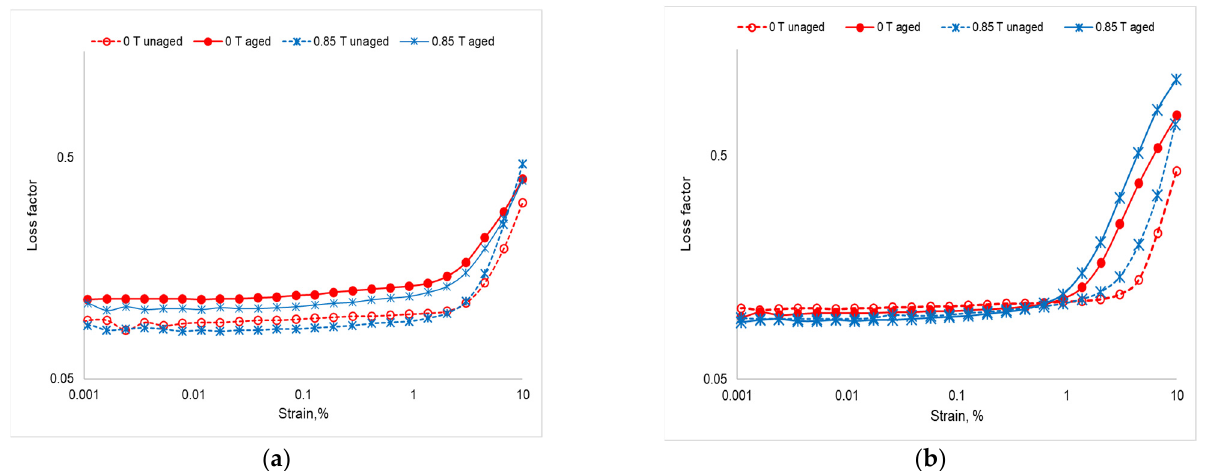
Figure 5. Comparison of loss factor of unaged and aged ( a ) SR-MRE samples with 30 wt% of CIPs and ( b ) SR-MRE samples with 60 wt% of CIPs.